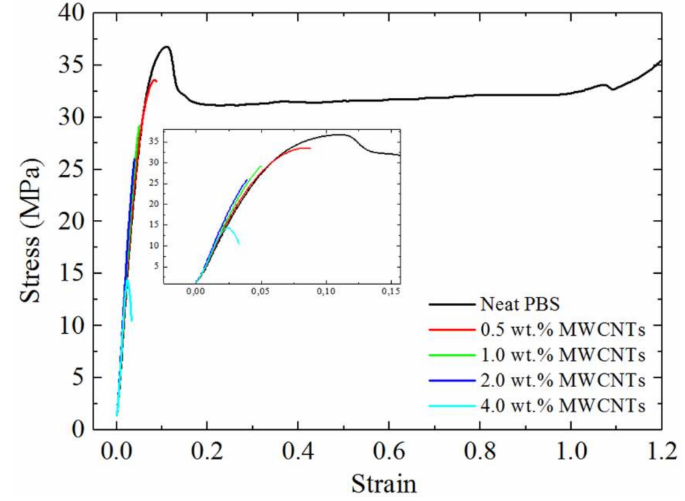
Figure 15. Stress-strain curves for neat PBS and the nanocomposites. Table 4. Summary of tensile testing results for neat PBS and the